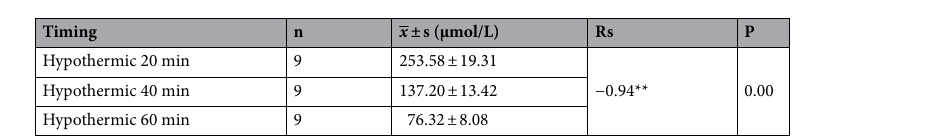
Figure 16. Changes of Glu content in brain extracellular fluid.